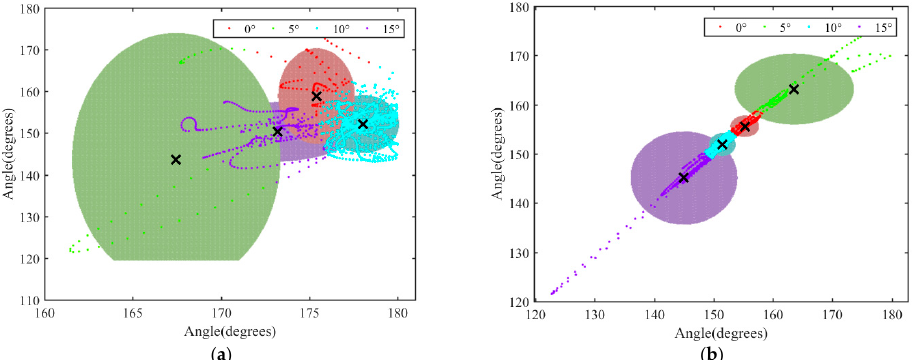
Figure 11. Clustering results of θ 3 data in the XZ and XY planes: ( a ) angle data of θ 3 in the XZ plane, when Sigmal was diagonal, and shared covariance was false; ( b ) angle data of θ 3 in the XY plane, when Sigmal was diagonal, and shared covariance was false.